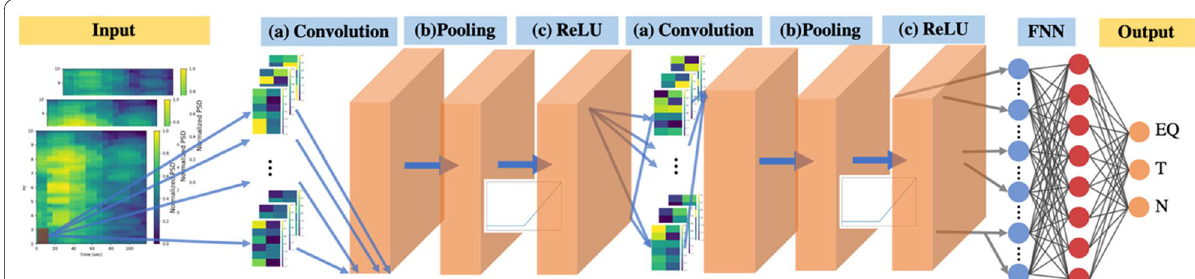
Fig. 2 Schematic diagram of a convolutional neural network (CNN). Input 2D images are sequentially processed in the following layers: a convolution, b pooling, c ReLU, and a fully connected neural network (FNN). The outputs are the EQ, T, and N